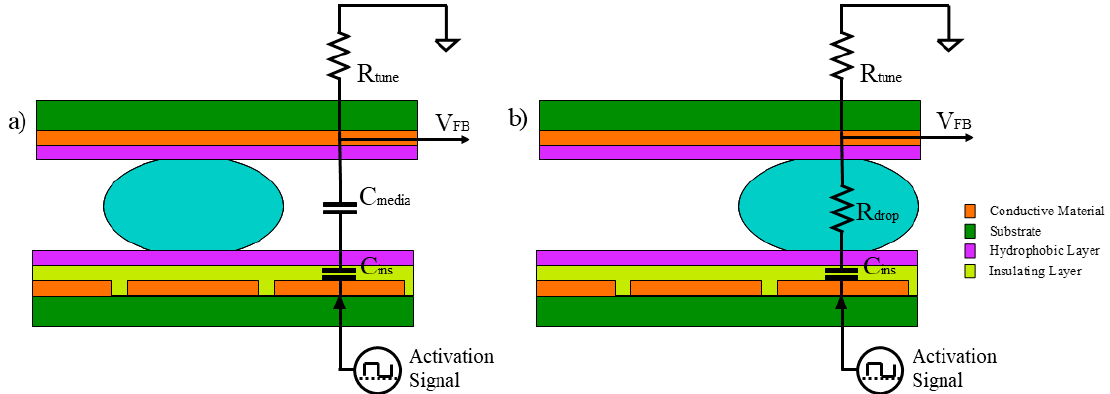
Figure 6. Droplet position equivalent circuit. ( a ) droplet not over the active pad; ( b ) after droplet has reached the active pad.